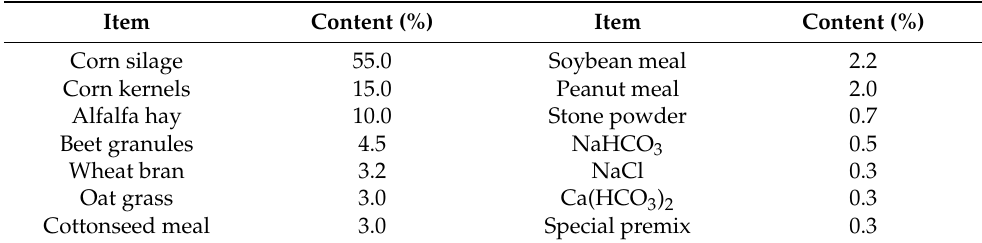
Table 1. Ingredient and chemical composition (mean) of the